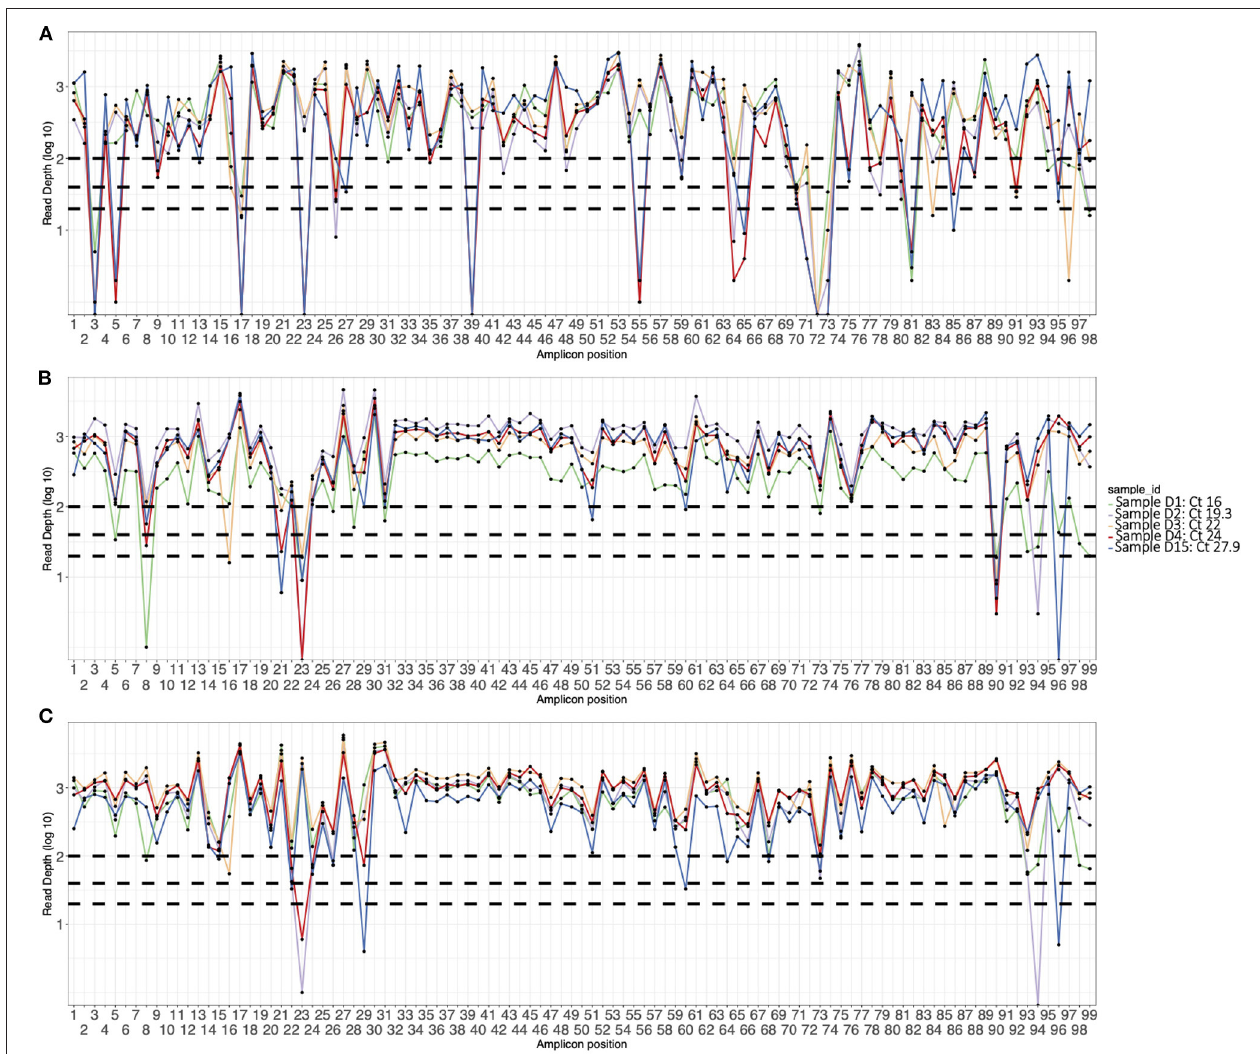
FIGURE 1 | Amplicon plots of five sequences generated using (A) V3 primers, (B) V4 primers, and (C) optimized V4 primers and classified as Delta VOC. The curves show average depth in log scale (y axis) per amplicon (x axis). The horizontal dotted lines indicate amplicon depth cut-offs at 23, 50, and